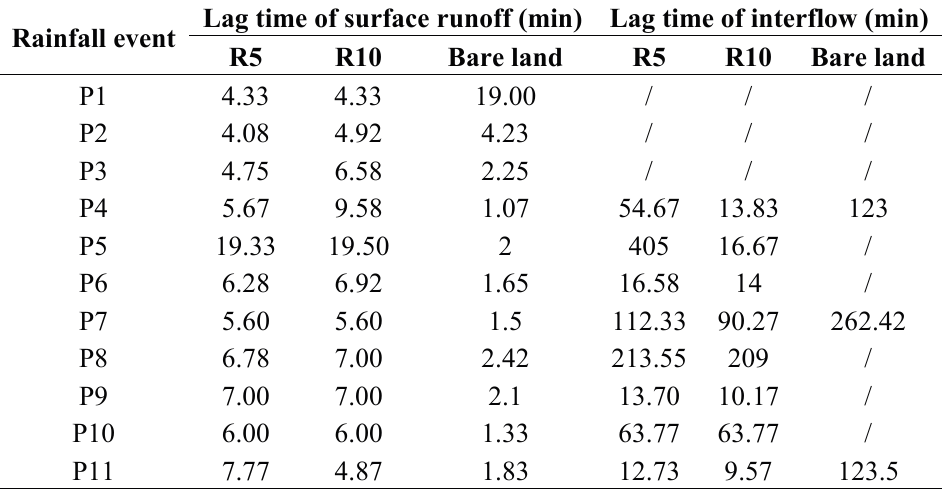
Table 6. Lag time of surface runoff and interflow for both grasslands and bare land plots. Rainfall